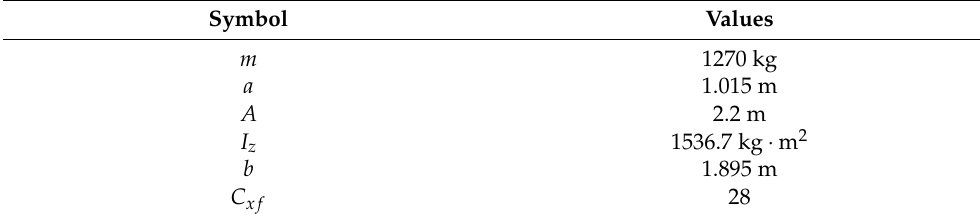
Table 3. The parameters of the vehicle model.